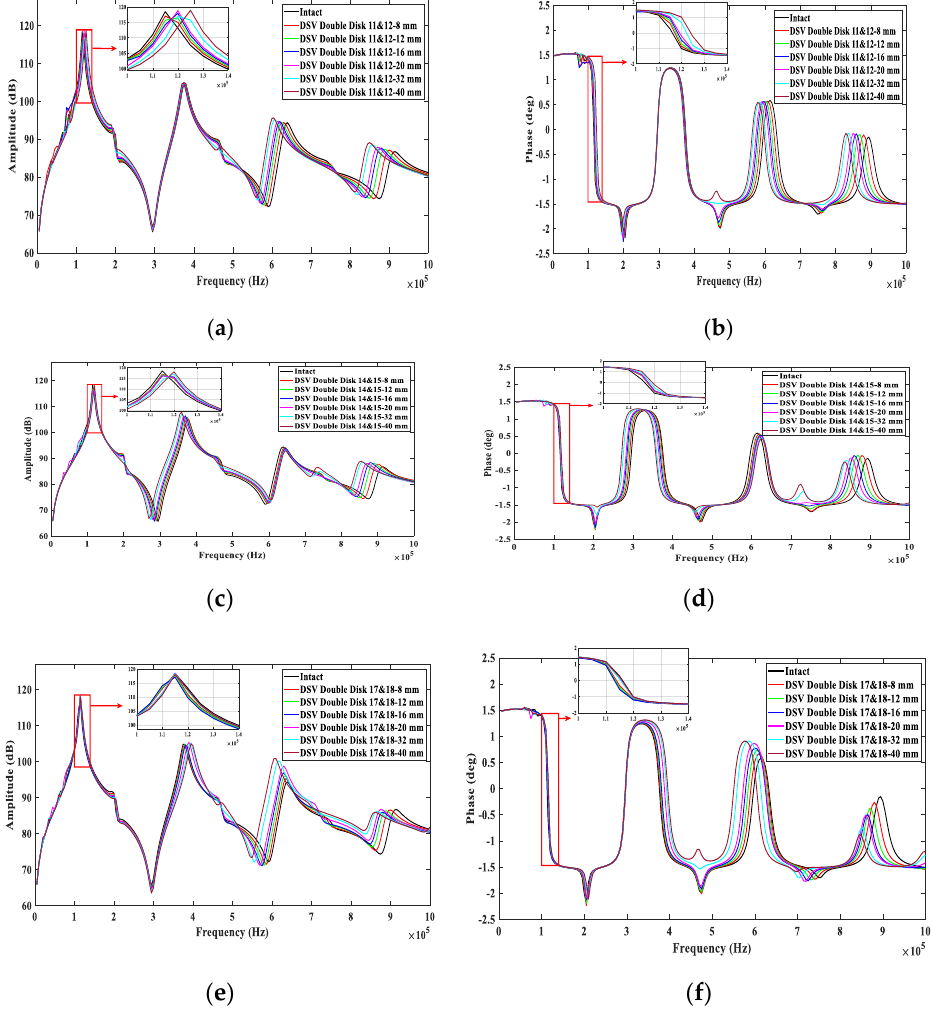
Figure 2. TF signatures illustrating intact and deformed traces, ( a ) the amplitude part of the TF for intact and DSV deformation between DD 11 and 12; ( b ) with the phase part of the TF for intact and DSV deformation between DD 11 and 12; ( c ) the amplitude part of the TF for intact and DSV deformation between DD 14 and 15; ( d ) with the phase part of the TF for intact and DSV deformation between DD 14 and 15; ( e ) the amplitude part of the TF for intact and DSV deformation between DD 17 and 18; and ( f ) with the phase part of the TF for intact and DSV deformation between DD 17 and 18.